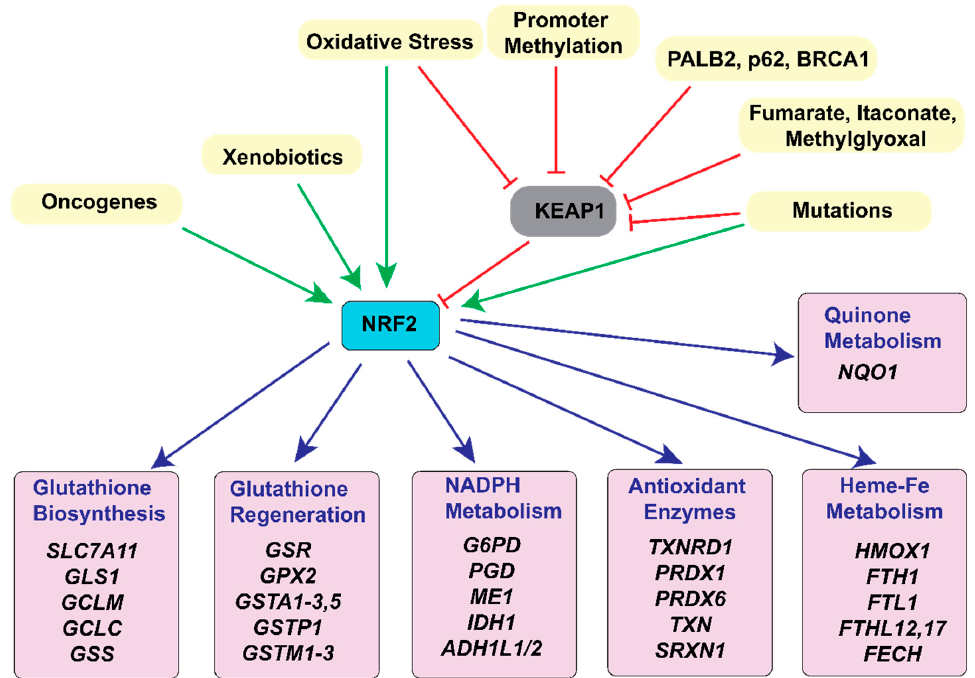
Figure 3. KEAP1-NRF2 in the regulation of metabolism and cellular antioxidant response. Nuclear factor erythroid 2-related factor 2 (NRF2) is the regulator of antioxidant response in cancer. NRF2 is activated by gene mutations, oncogene activation, xenobiotics, or oxidative stress. Oxidative stress also inactivates the principal NRF2 inhibitor in cells, Kelch-Like ECH-associated protein 1 (KEAP1), KEAP1-sequestering proteins like PALB2, BRCA1, and p62, and interaction with metabolites such as fumarate, itaconate, and methylglyoxal. Stabilized NRF2 regulates expression of several genes involved in redox homeostasis. Shown here are NRF2-target genes involved directly in redox balance. First glutaminase1 (GLS1), glutamate-cysteine ligase, modifier subunit (GCLM), glutamate-cysteine